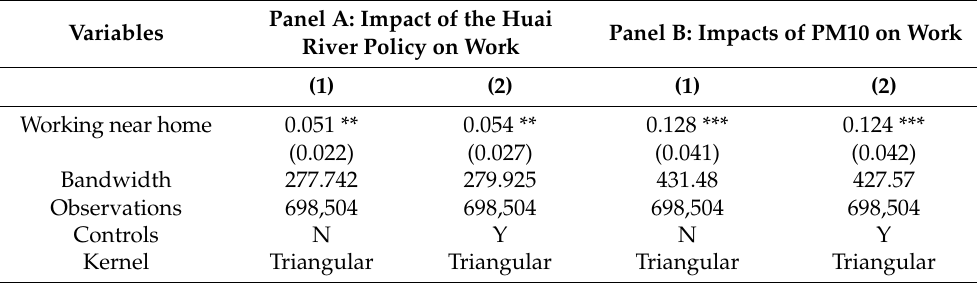
Table A5. RD estimates for samples with a residence duration at the same prefecture-level city of more than 5